Question: Which visualization type does this figure use?
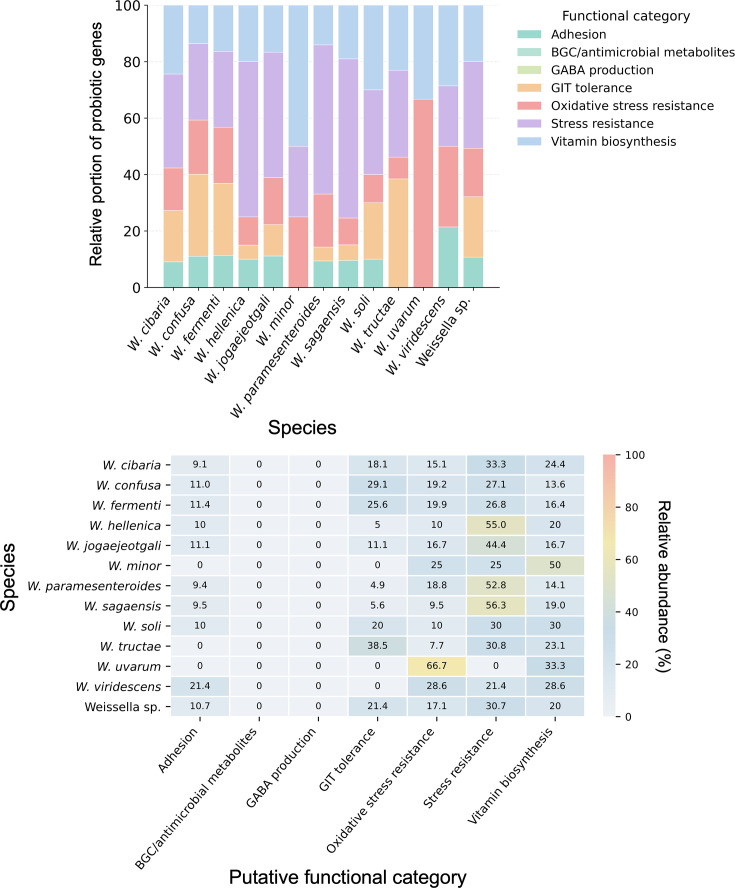
Answer: heatmap